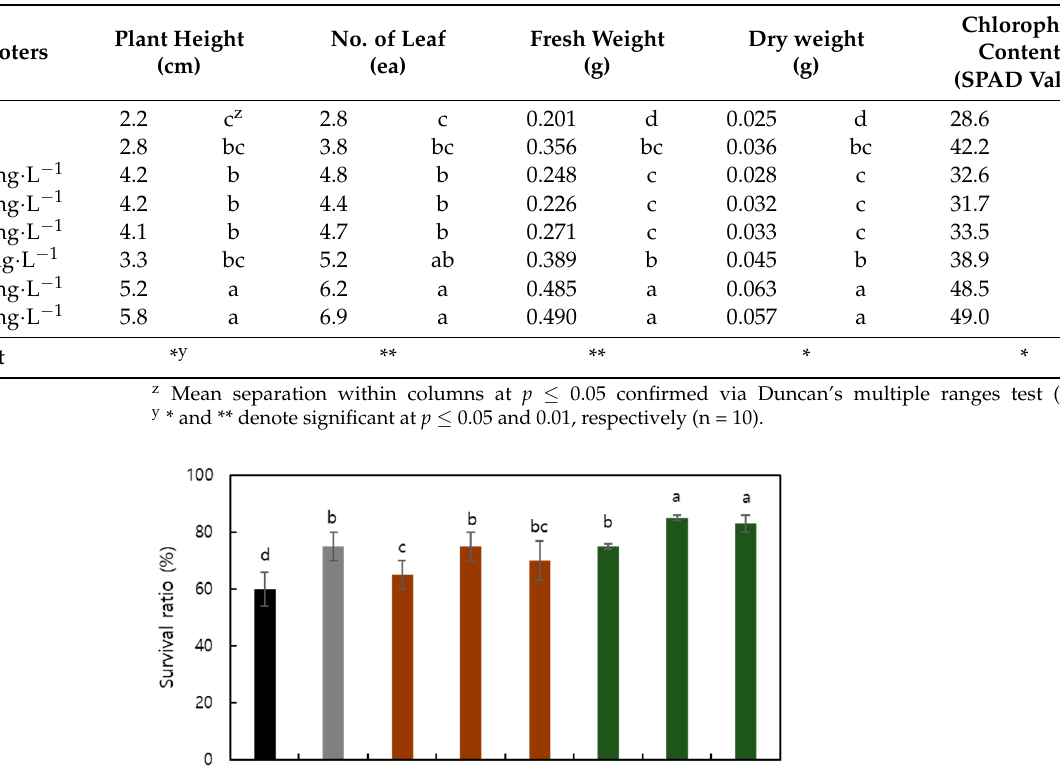
Table 3. Characteristics of shoot growth as affected by rooting promoters at 70 days after cutting Rhododendron micranthum Turcz.